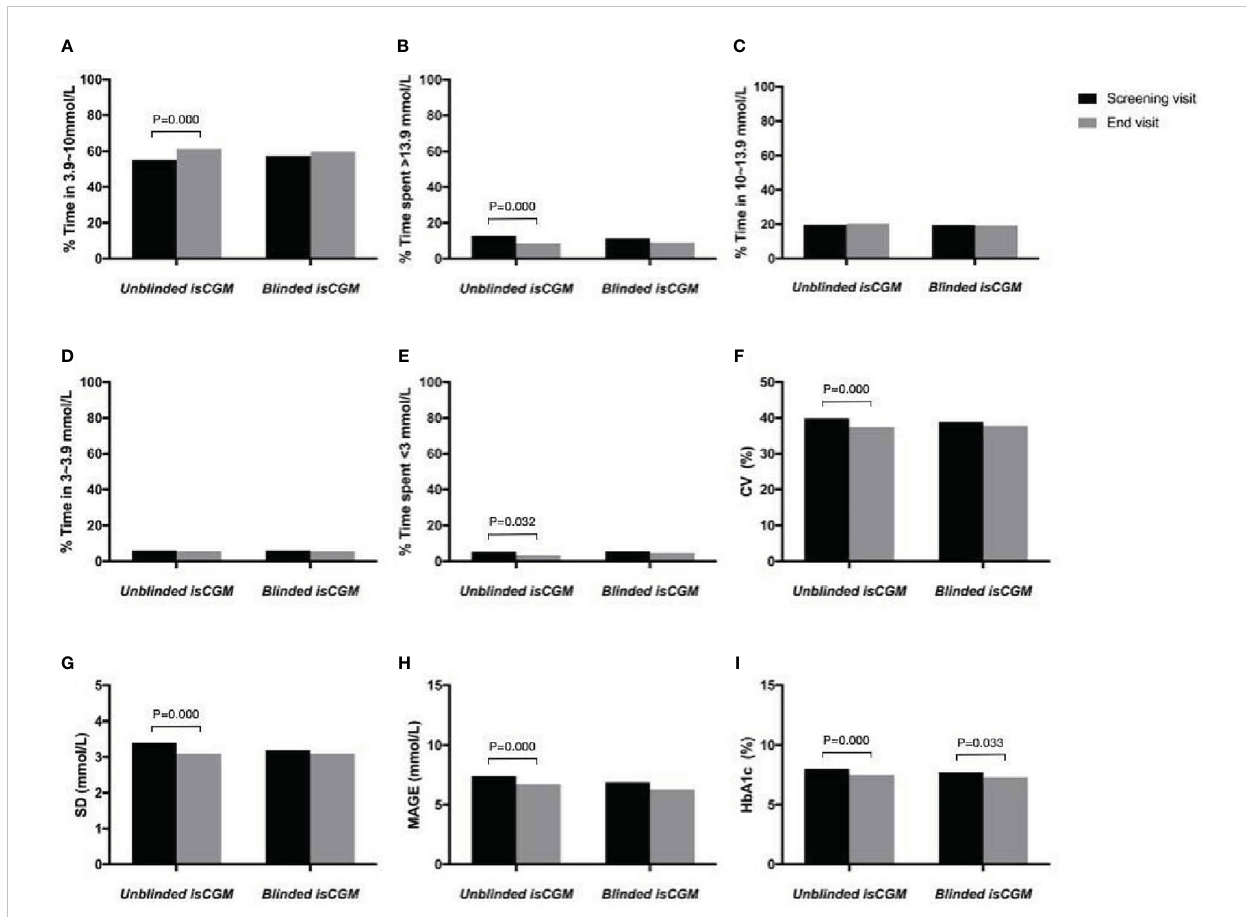
FIGURE 5 The ef fi cacy of unblinded and blinded intermittently fl ash continuous glucose monitoring on glycemic control in adults with type 1 diabetes. Percentage of time in range (A) , hyperglycemia (B, C) , hypoglycemia (D, E) , Glucose variability (F – H) and HbA1c (I)